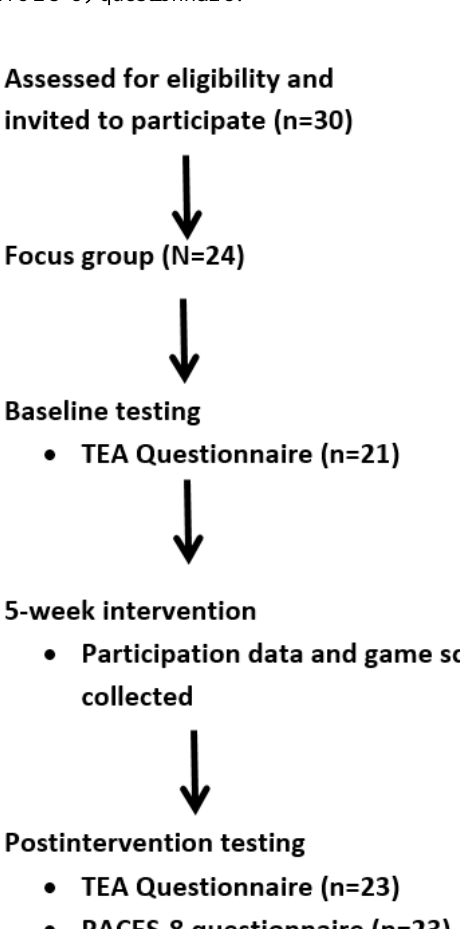
Figure 1. Study flow